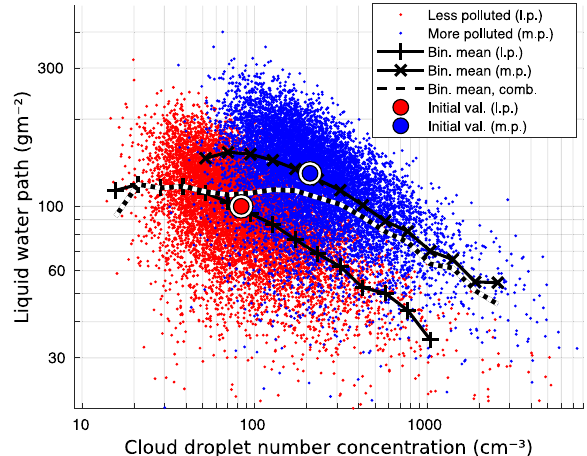
Fig. 4 | Simulation of less and more polluted cases. For less polluted case (red dots) assuming values of cloud effective radius (CER) and liquid water path (LWP) of 13 μ m and 100gm − 2 , respectively, and for more polluted case (blue dots) values of CER and LWP of 10 μ m and 130gm − 2 , respectively. Relative error of 25% was assumed for both cloud optical depth (COD) and CER. Cloud droplet number concentration (CDNC) binned mean values of LWP are shown for both cases separately and also for the combined dataset including both cases (dashed line). LargeredandbluecirclesshowtheinitialvaluesforCDNCandLWPforthelessand more polluted case,